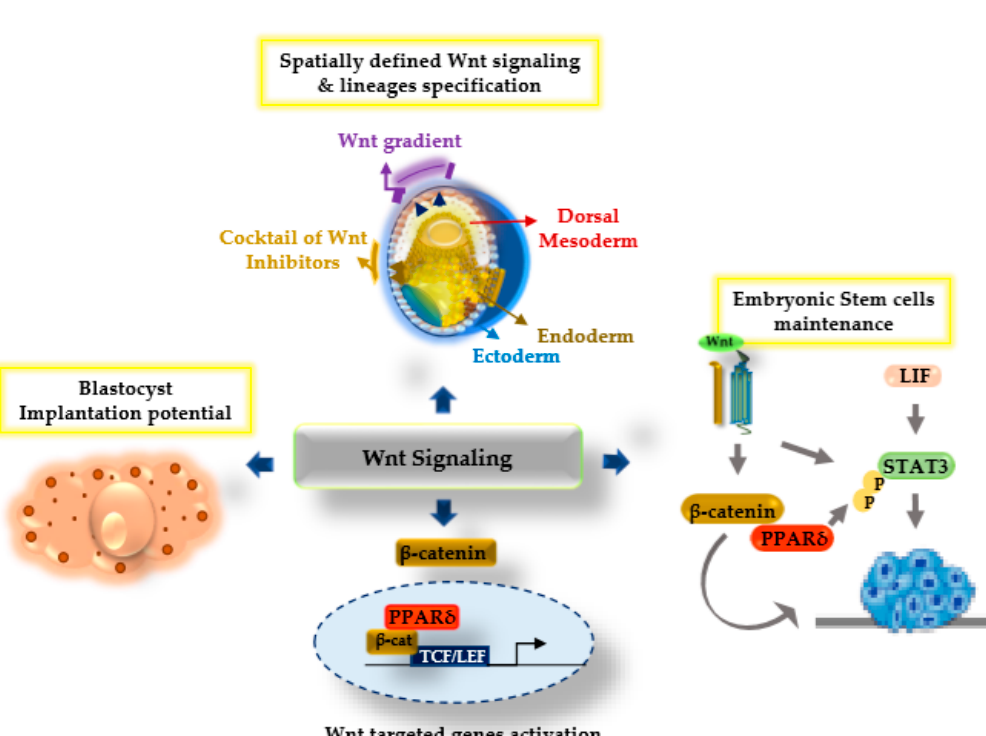
Figure 2. Model diagram illustrating the Wnt/ β -catenin signaling and PPAR δ synergistic functions regulating several aspects of development. Upon Wnt stimulation, the β -catenin and PPAR δ transcriptional complex with the T cell factor/lymphoid enhancer factor (TCF/LEF) plays a crucial role during the specification of embryonic lineages, and enhances blastocyst implantation potential and the regulation of embryonic stem cell maintenance.